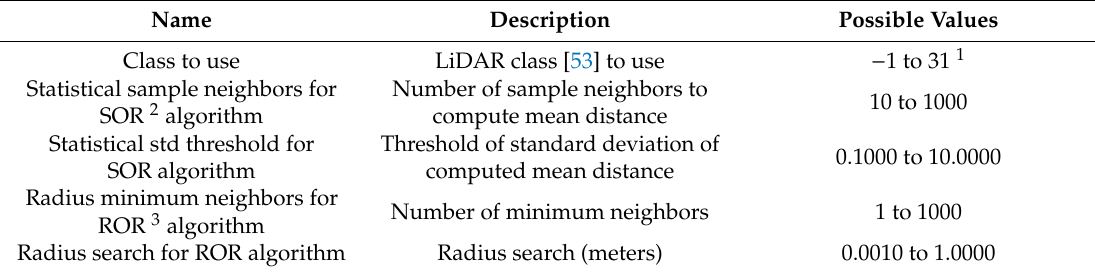
Table 4. List of editable parameters for the remove outliers